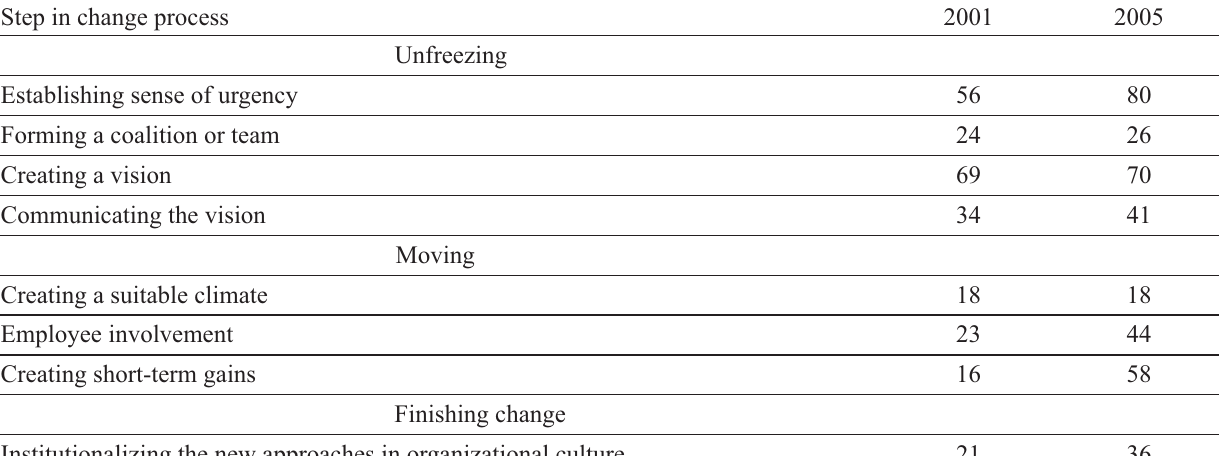
Table 2. Steps in implementation of the change process in Estonian companies (% of companies) Step in change